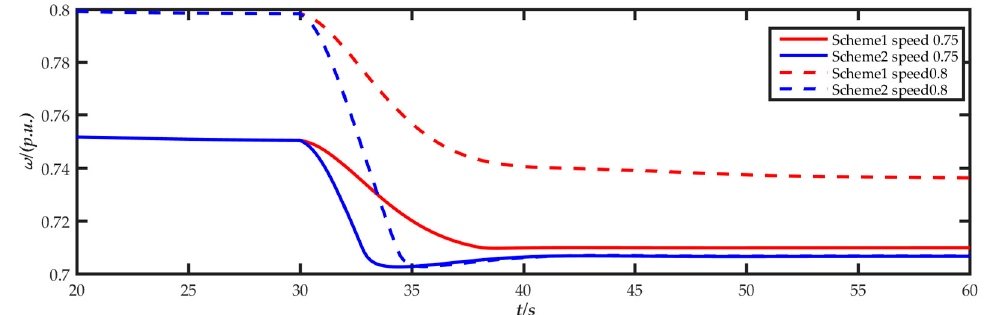
Figure 9. Speed change in wind turbines in the low-wind speed zone.